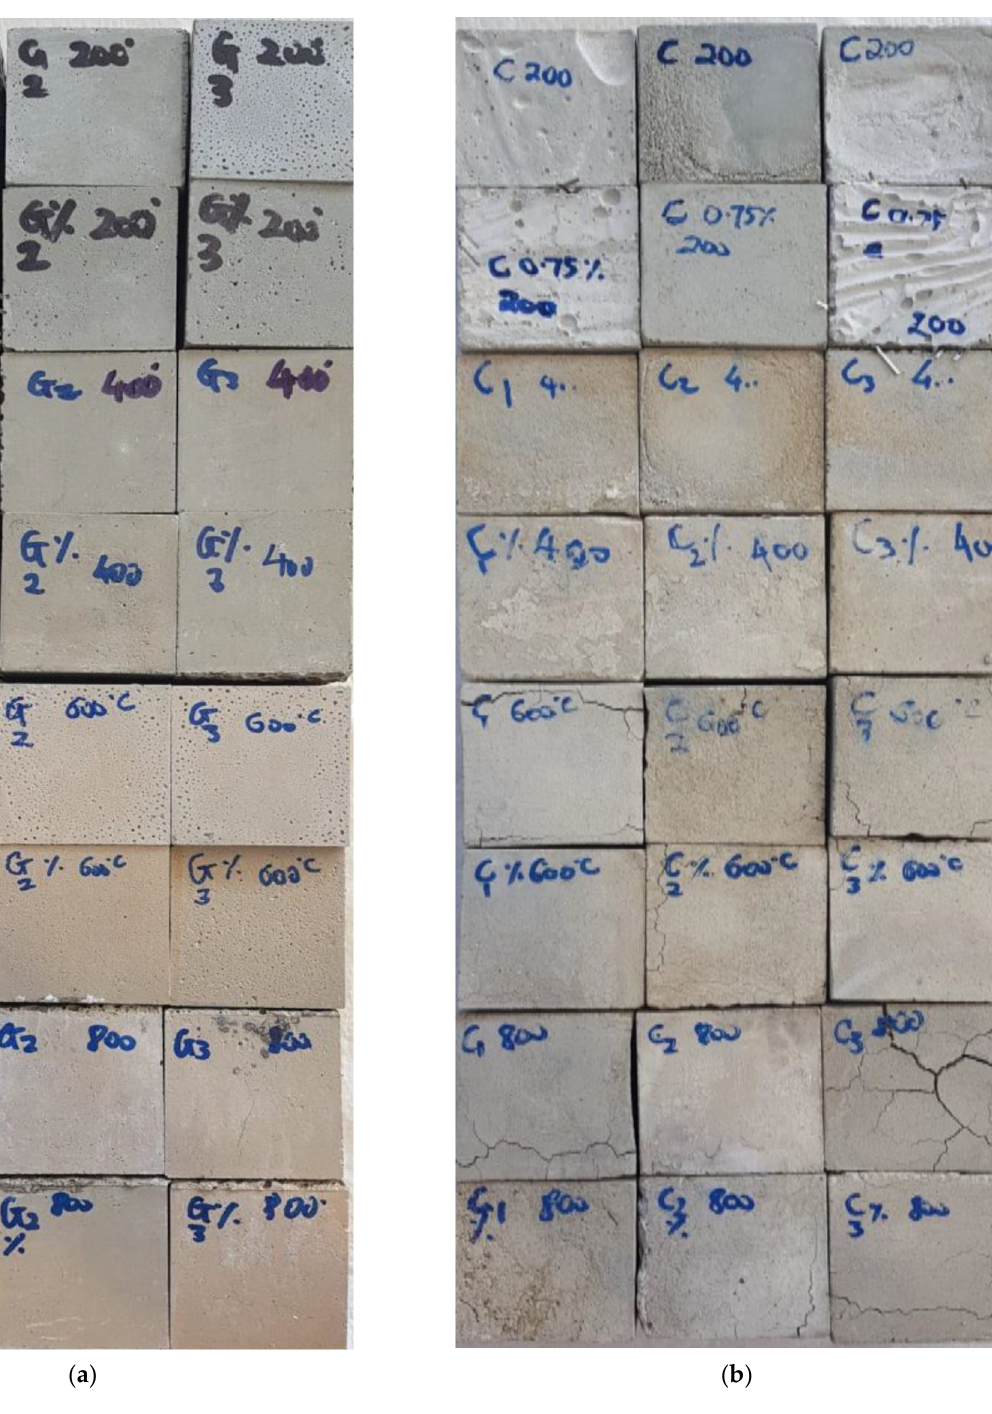
Figure 4. Cracking behavior of composites at elevated temperatures ( a ) Cement composites ( b ) Ge- opolymer composites. ( b ) Geopolymer